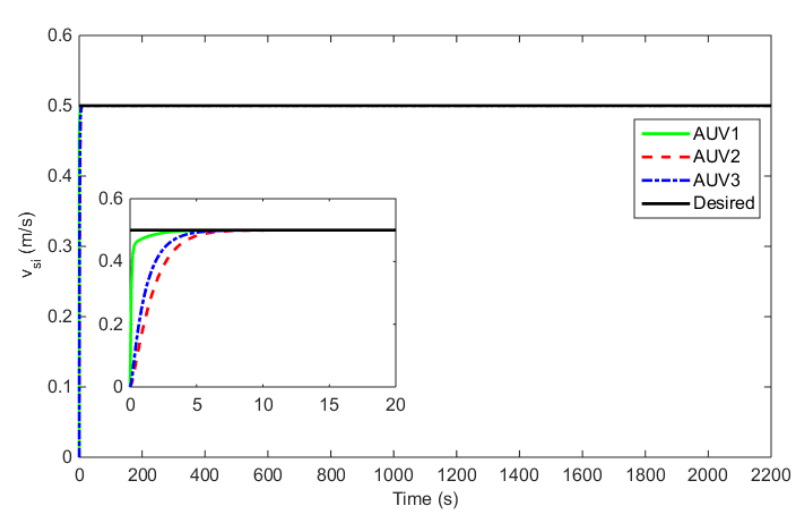
Figure 12. Control inputs of three AUVs.